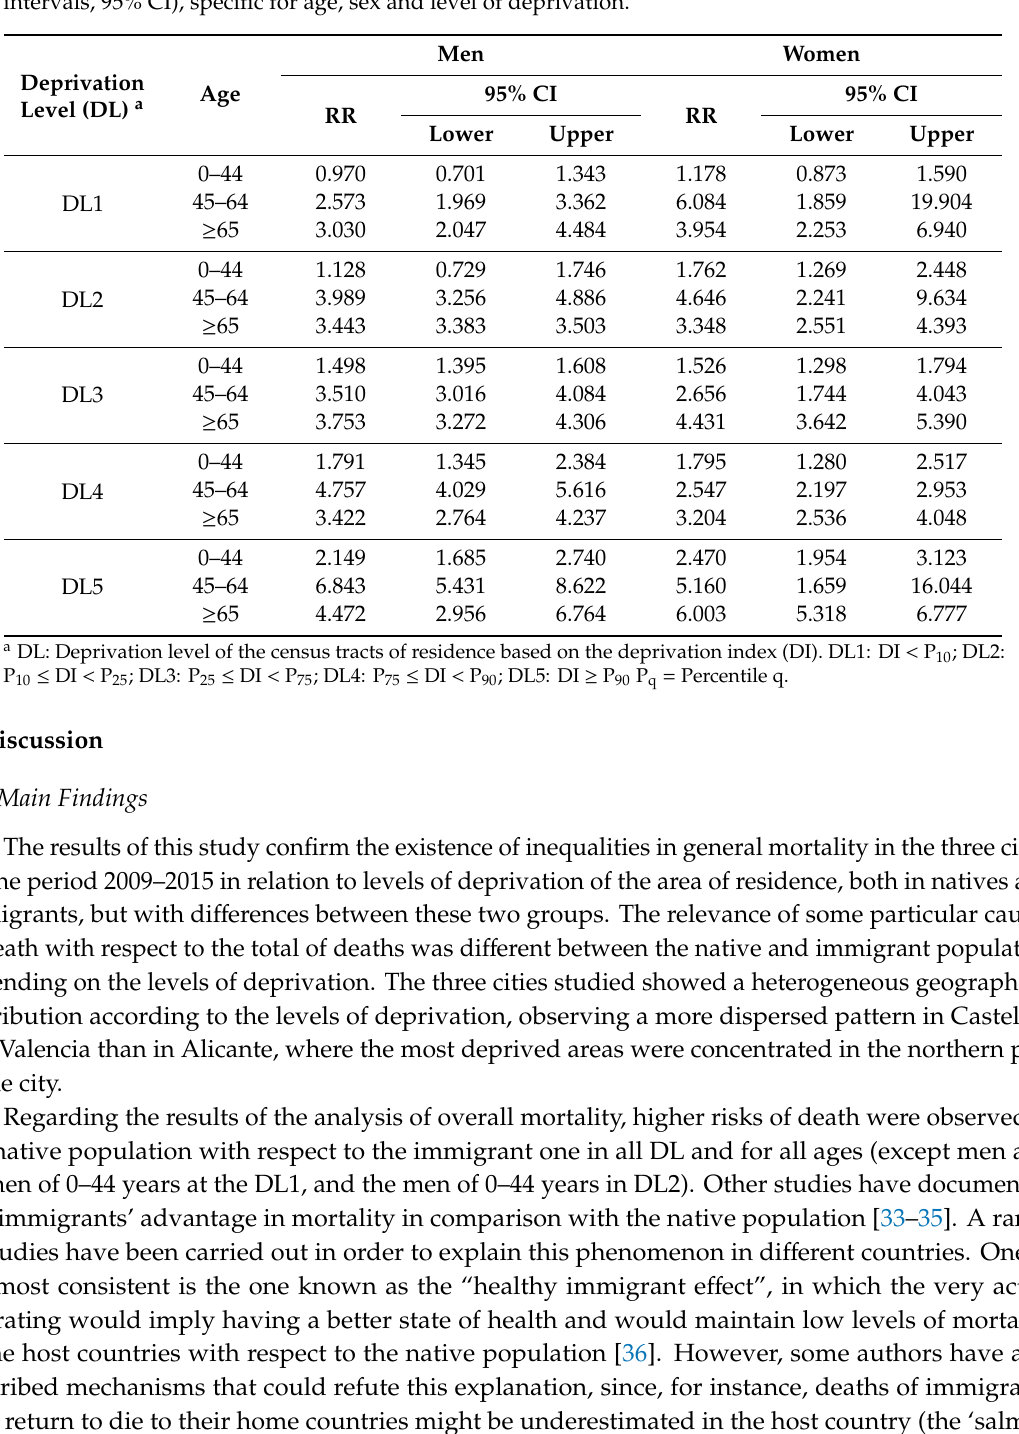
Table 5. Relative risks of death from all causes in Spanish-born versus foreign-born (and 95% confidence intervals, 95% CI), specific for age, sex and level of